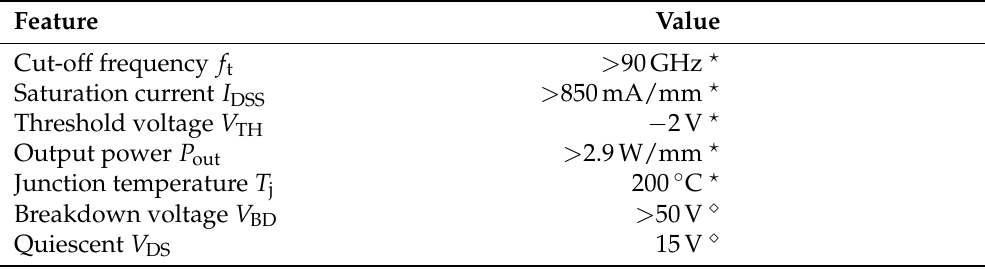
Table 1. Features of the OMMIC D01GH GaN-on-Si process.